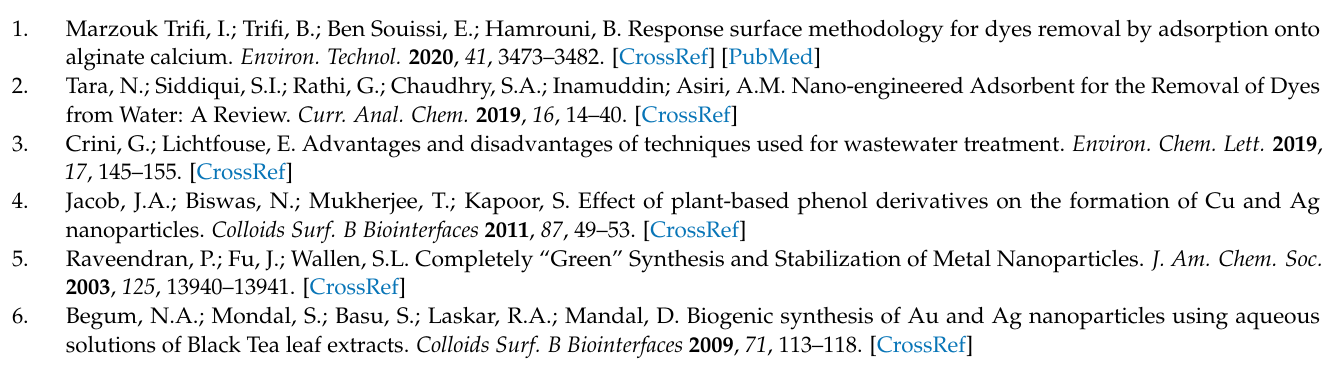
methanol-hexane (C) and synthesized OMAgNs (D). Figure S3: Absorption spectra of synthesized OMAgNs. Figure S4: SEM images at 100,000 × (A), 300,000 × (B) magnification and EDX (C) analysis of A-OMAgNs. Figure S5: SEM images at 100,000 × (A), 300,000 × (B) magnification and EDX (C) analysis of M-OMAgNs. Figure S6: SEM images at 100,000 × (A), 300,000 × (B) and EDX (C) analysis of MH-OMAgNs. Table S1: Absorbance values for first, second and third round of M-OMAgNs and extract (shown as